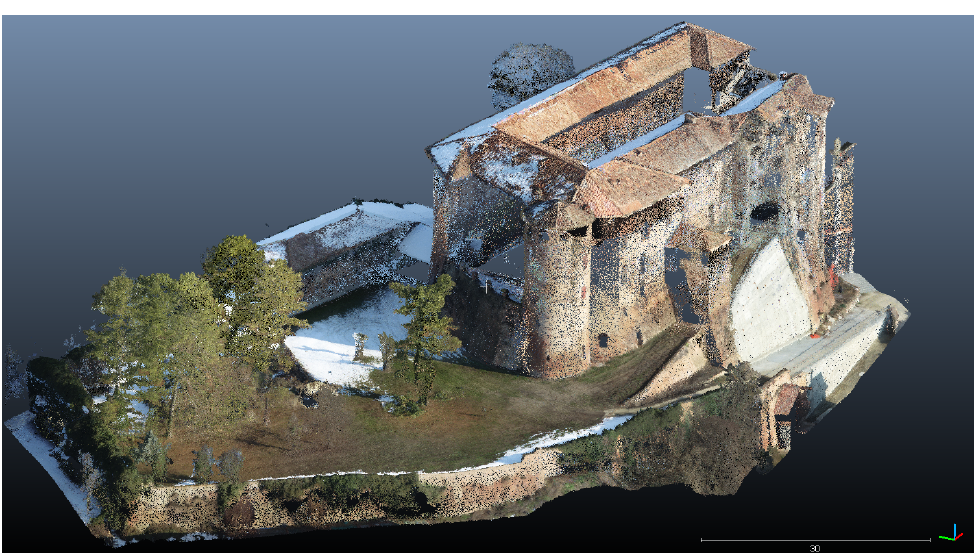
Figure 5. Zenmuse L1 point clouds data related to the castle and the near surroundings within the perimeter walls.